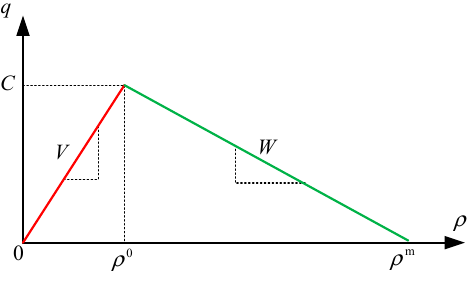
Figure 1. Triangular fundamental diagram.